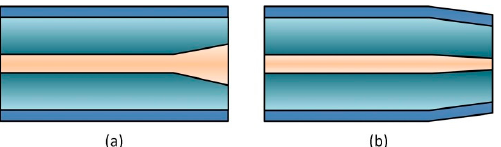
Figure 2. Scheme of changes in optical fibers as a result of thermal core expansion ( a ) and physical tapering ( b ). tapering ( b